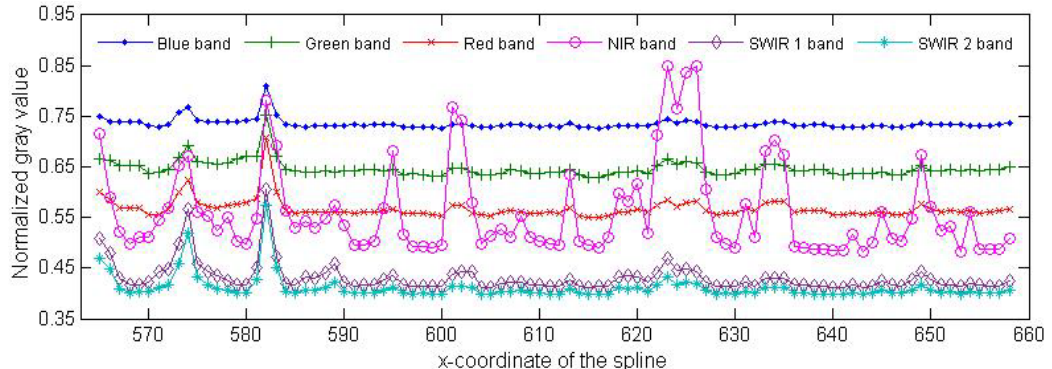
Figure 2. Pixel grey values of the different bands from a sample line, including pen facility and water, etc.